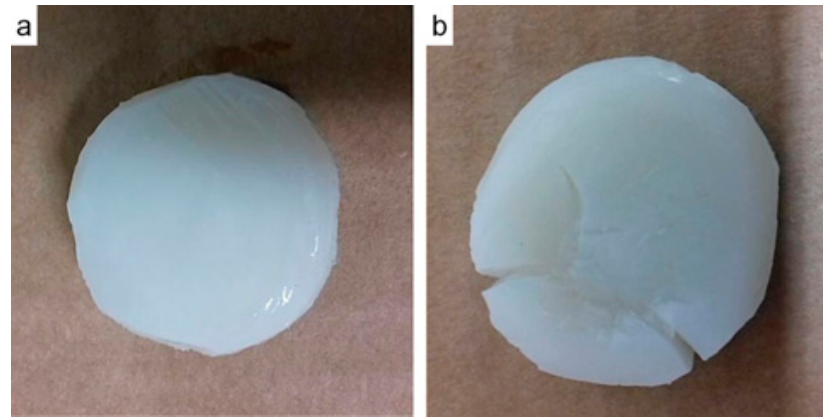
Figure 6. ( a ) Hydrogel before and ( b ) after fracturing by monotonic compression. Table 4. Ultimate compression test results and elastic modulus of hydrogel samples.